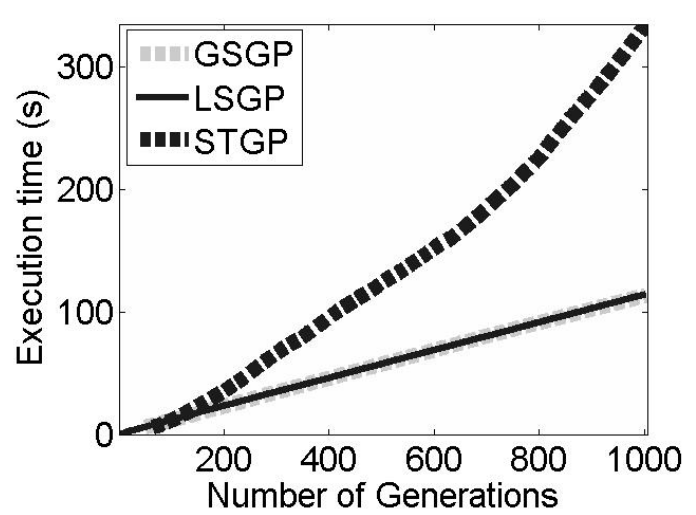
Figure 1. Comparison between the execution time of different GP systems. GSGP stands for Geometric Semantic Genetic Programming, the GP system that uses the GSC and GSM operators; LSGP is the GSGP version in which the GSM operator is combined with the local search operator; STGP refers to the traditional GP algorithm that makes use of standard syntax-based genetic operators.